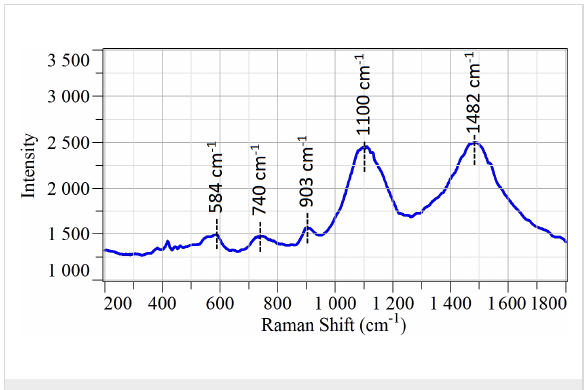
Figure 2: Raman spectrum of NiO nanowires deposited on alumina substrate measured in ambient air at room temperature.